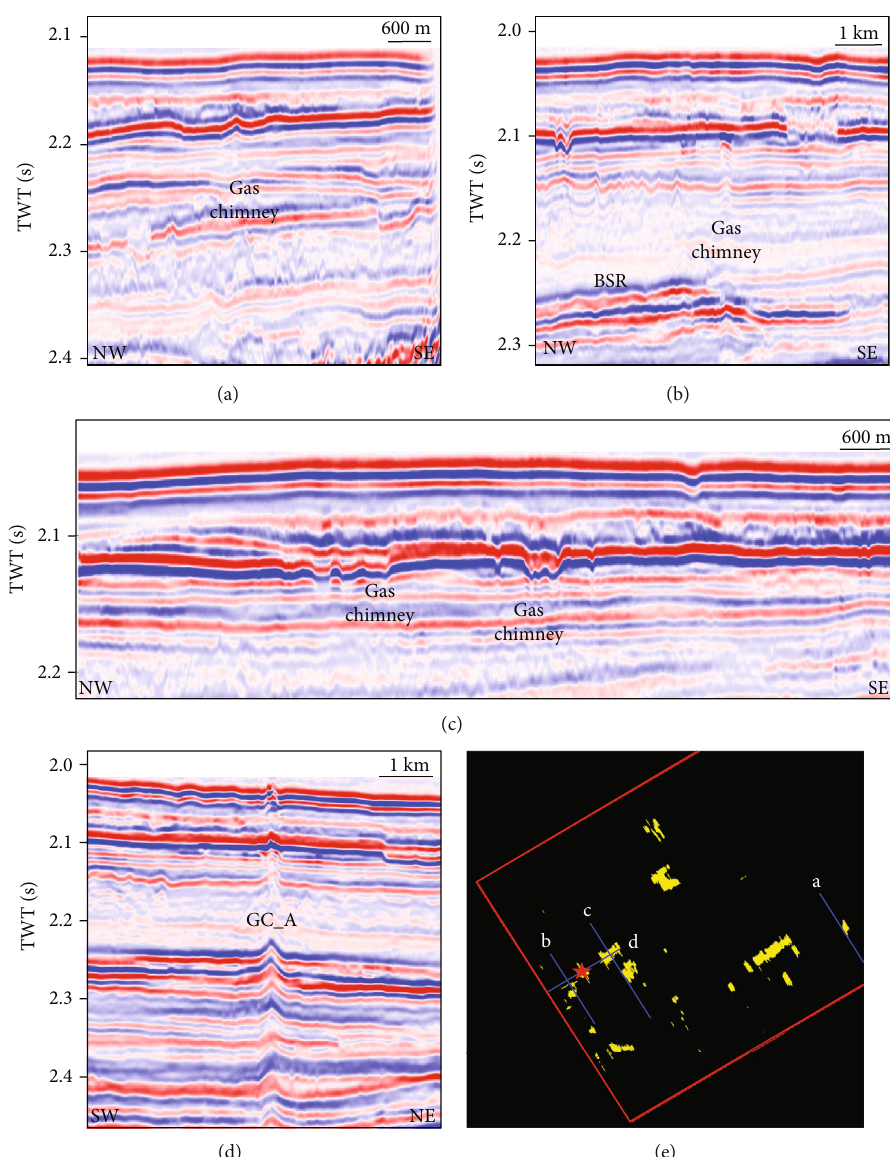
Figure 7: (a – d) Seismic sections and (e) distributions of the shallow gas chimneys in the study area. The yellow areas in panel (e) indicate shallow gas chimneys, the blue lines represent seismic lines shown in panels (a – d), and the red star labels the newly discovered cold